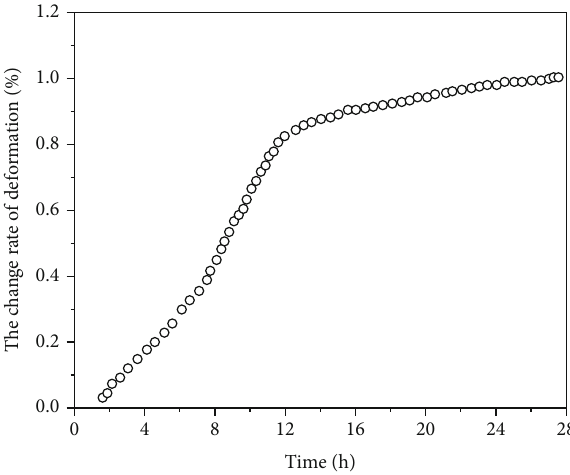
Figure 10: The change rate of deformation vs. time for